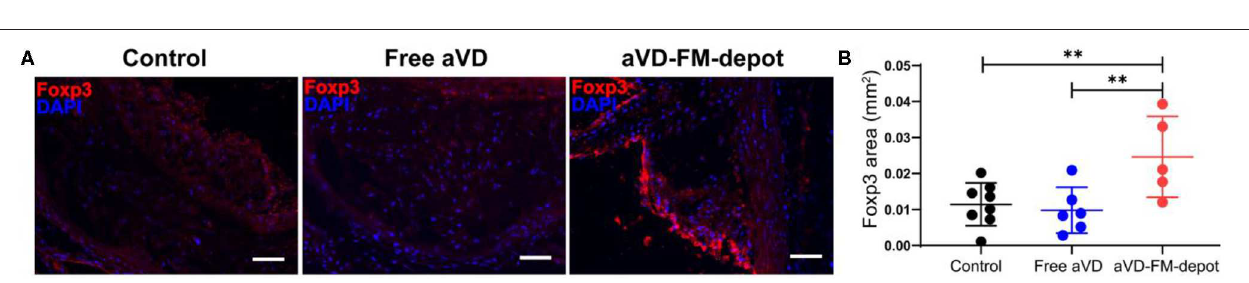
( Figure 4C ) for the aVD-FM-depot treatments compared to